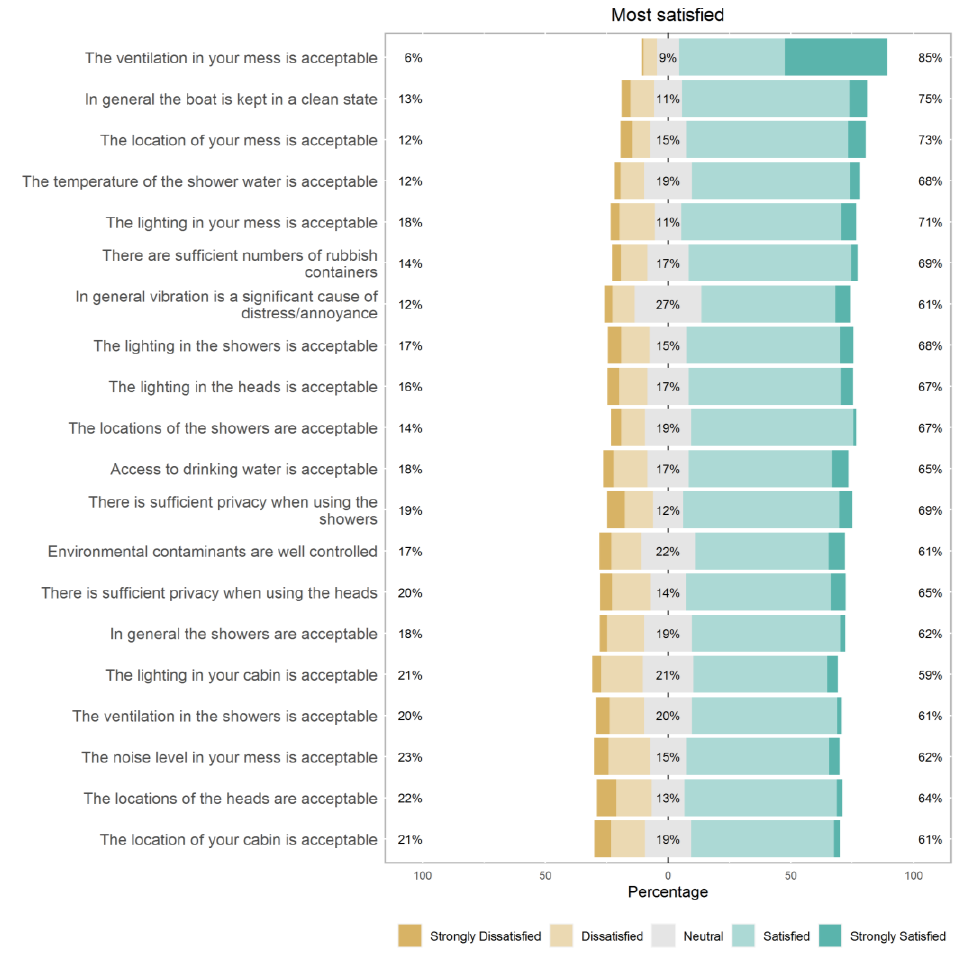
Figure 1. Items with the highest (top) mean satisfaction ratings. Note some items have been reverse coded to reflect low to high satisfaction. Values reflect (left to right) the percent of combined strongly dissatisfied and dissatisfied responses, percent of neutral responses, and percent of combined satisfied and strongly satisfied responses.